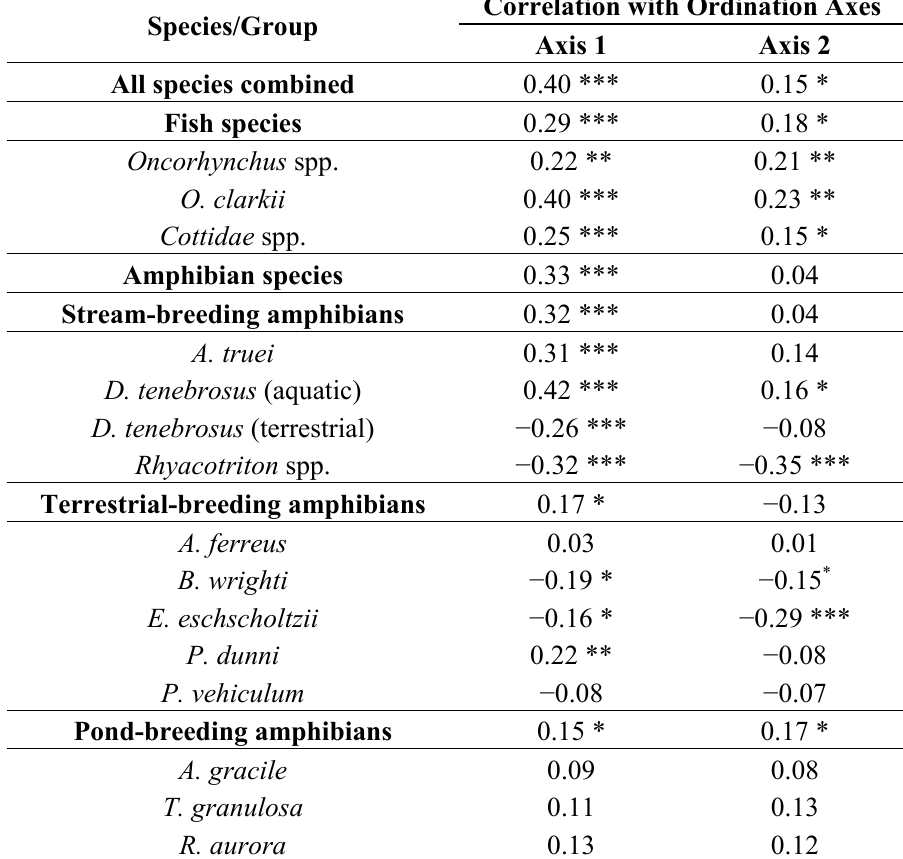
Table 3. Correlations of species densities with axes from the ordination of reaches described by habitat